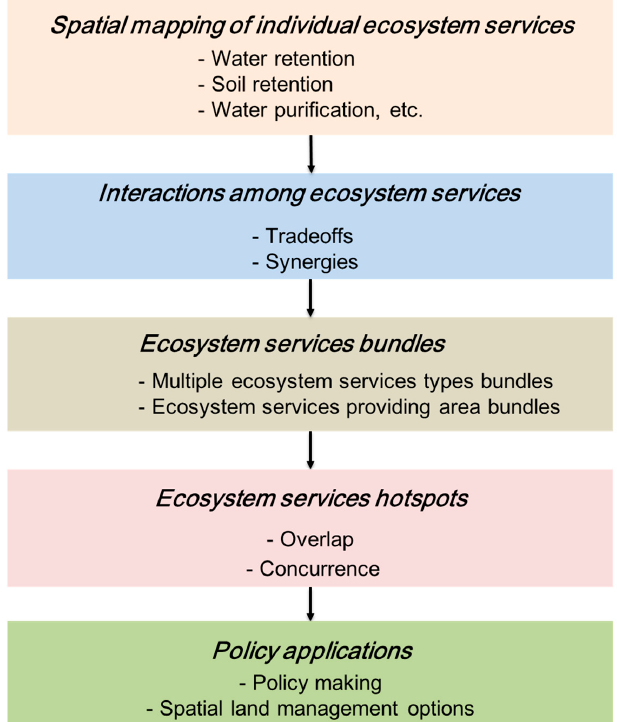
Figure 2. Methodology framework of the research.